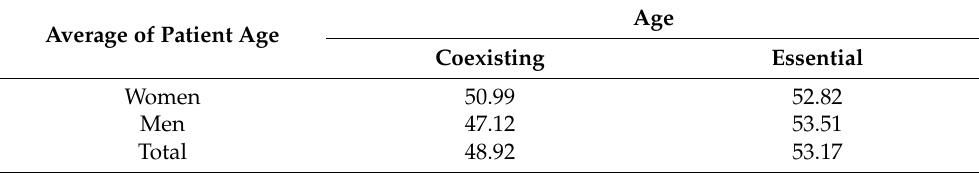
Table 2. Average age of analyzed group.